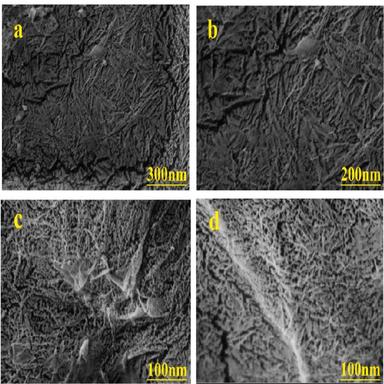
Top-view SEM images of nanocomposite films with different ratios of CNF/CNC: (a, b) CNF: CNC = 5:5, (c) CNF: CNC = 8:2; (d) Cross sectional SEM images of CNF/CNC nanocomposite film (CNF: CNC = 5:5).